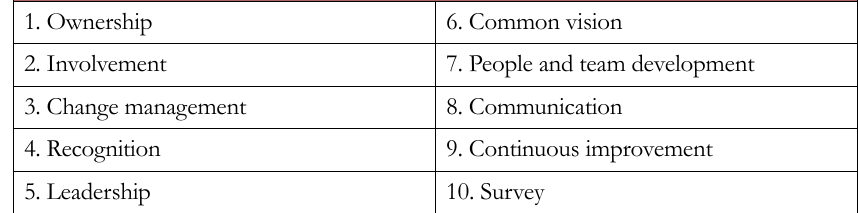
Table 2. Main OCTM working elements based on work environment point of